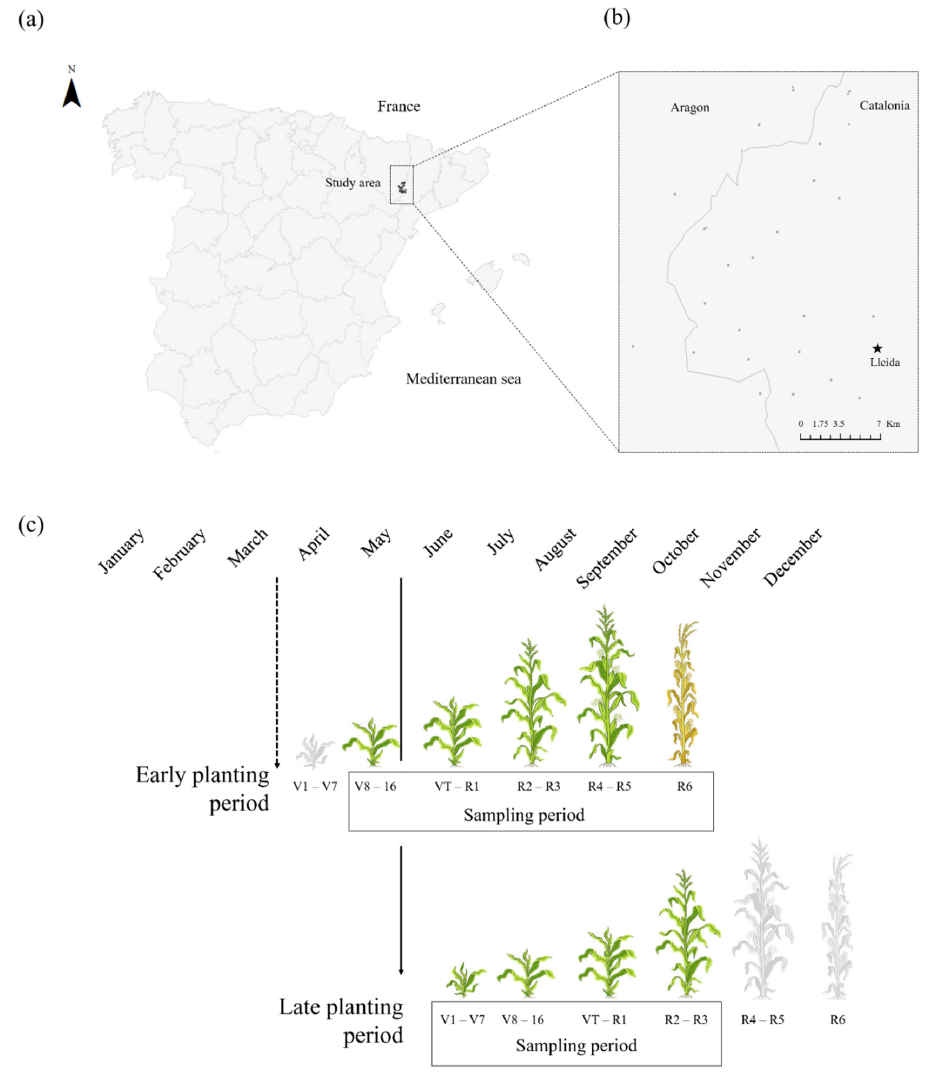
Figure 1. Maize-growing areas in Ebro valley, northern Spain: ( a ) study area, ( b ) the maize fields sampled, and ( c ) the two common planting periods in the area (early and late) with the maize phe- nology.